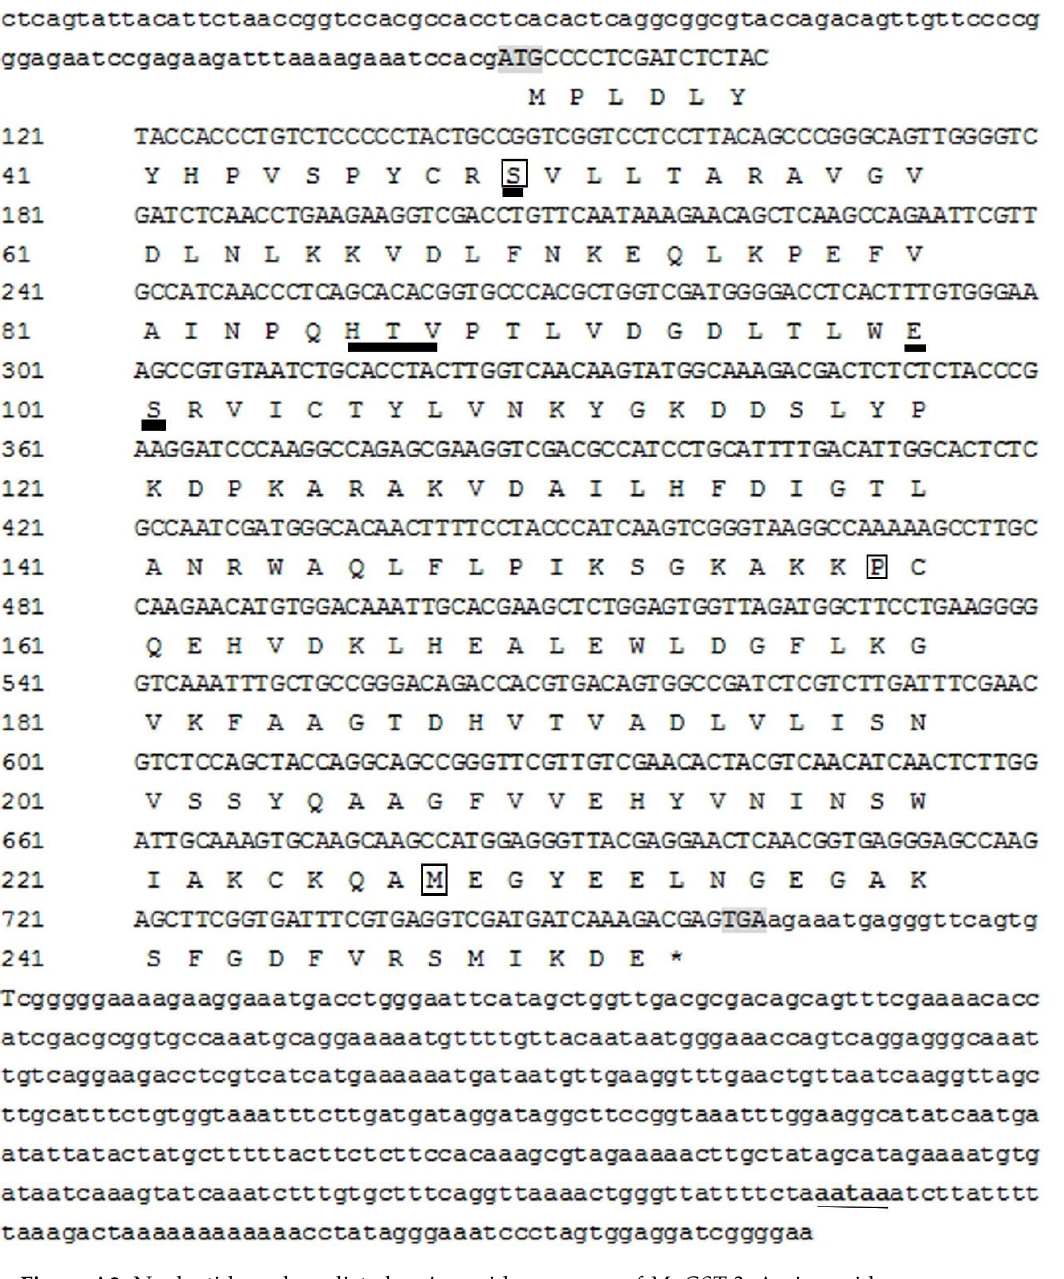
Figure A2. Nucleotide and predicted amino acid sequences of MnGST-2 . Amino acid sequences are shown as capital letters below the nucleotide sequences. Black rectangles indicate the three potential O-GlcNAc sites. Black underlines indicate highly conserved residues. The start codon (ATG) is boxed. The stop codon (TGA) is shaded in grey. The protein translation terminator was denoted with an asterisk. The AATAA sequence is a potential polyadenylation signal, represented by an underscore.